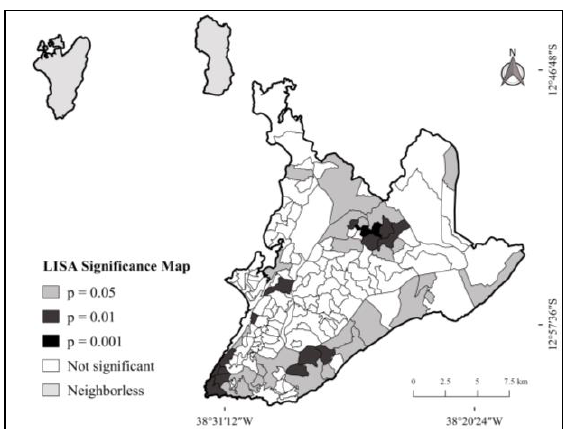
Figure 6 . LISA Significance test. Salvador,